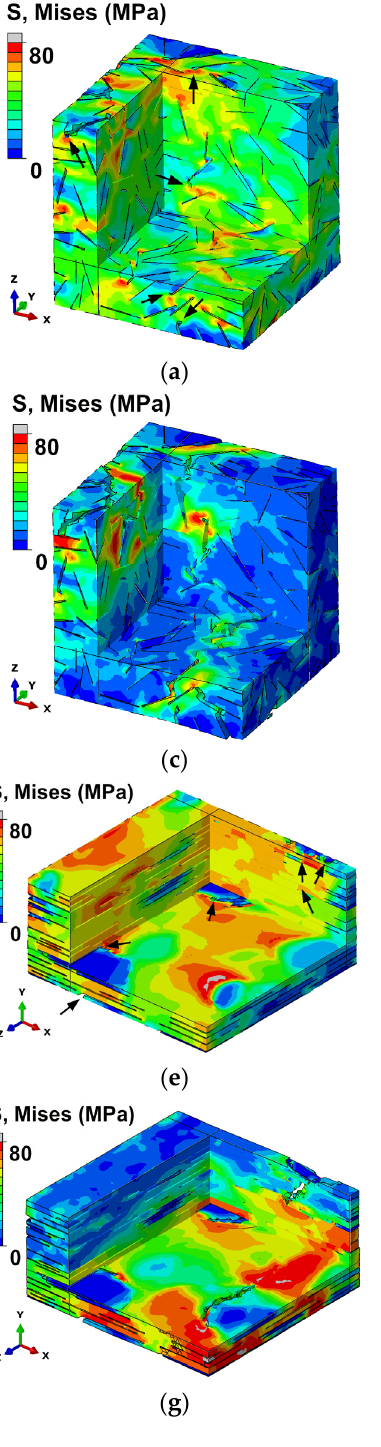
Figure 2. Stress distribution inside RVEs demonstrating crack formation and propagation (cut views): ( a ) RVE with randomly placed inclusions at a strain of 0.026, ρ G = 500, ρ MX = 125, f G = 0.1%, f MX = 1.6%, and E MX = 0.5 E m (localized cracking is indicated by the black arrows); ( b ) at a strain of 0.029; ( c ) at a strain of 0.031; ( d ) completely fractured at a strain of 0.038; ( e ) the RVE with aligned inclusions at a strain of 0.032, ρ G = 500, ρ MX = 250, f G = 0.1%, f MX = 3.2%, and E MX = 0.5 E m (localized cracking is indicated by the black arrows) at a strain of 0.036; ( f ) at a strain of 0.039; ( g ) at a strain of 0.041; ( h ) completely fractured at a strain of